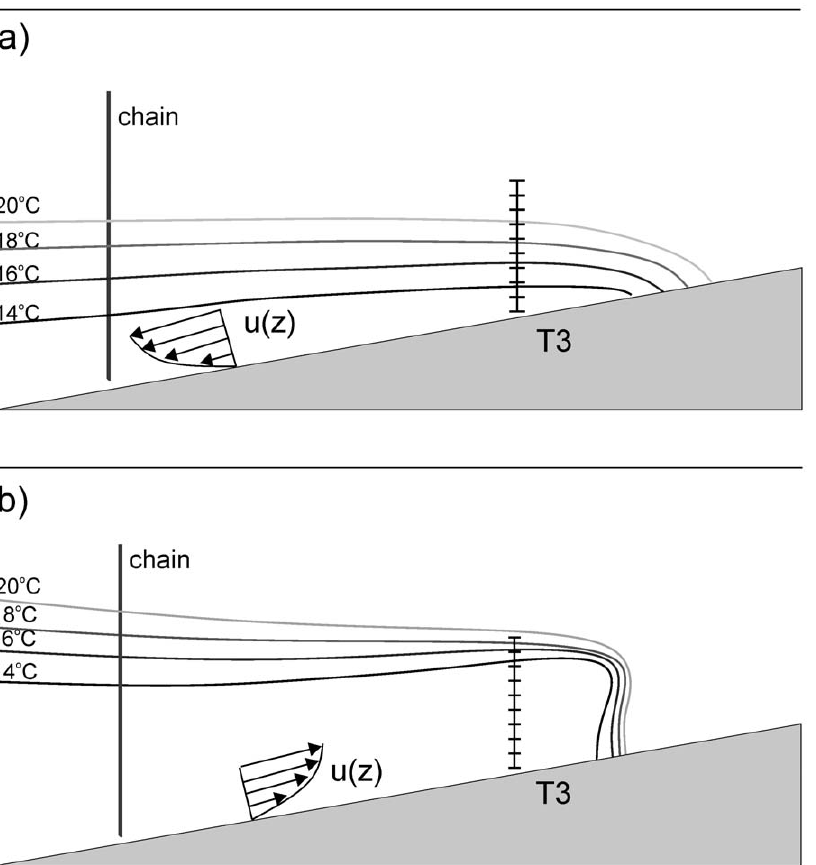
Figure 6. A schematic diagram describing the asymmetry in stratification between up and downwelling events. The position of isotherms is shown at both the deep mooring and the benthic mooring. a) During downwelling events there is a stable stratification in the water column. b) During upwelling events the isotherms resemble a ‘bore-like’ structure due to cold water that advances fast from deeper parts of the lake along the shallow